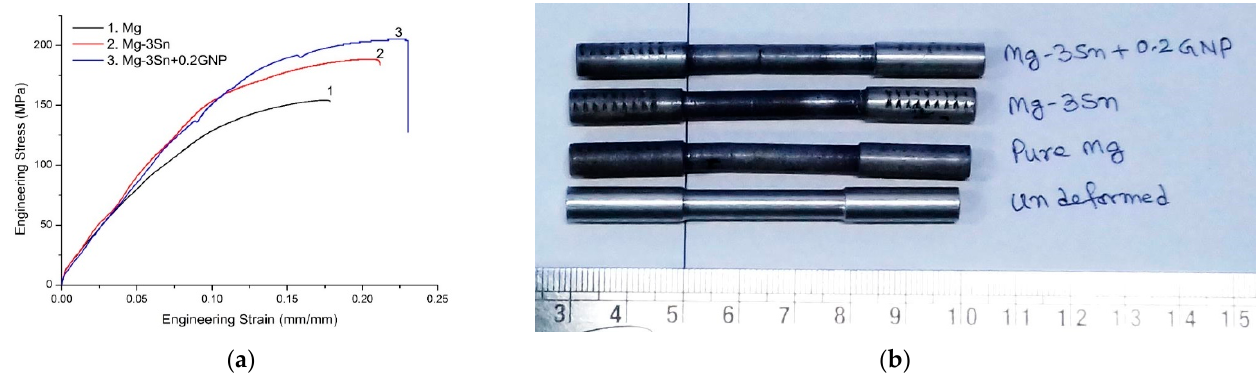
Figure 8. Tensile behavior of pure Mg, Mg-3Sn alloy, and Mg-3Sn + 0.2 GNP composite: ( a ) representative tensile engineering stress–strain curve and ( b ) corresponding images of undeformed and deformed tensile samples.